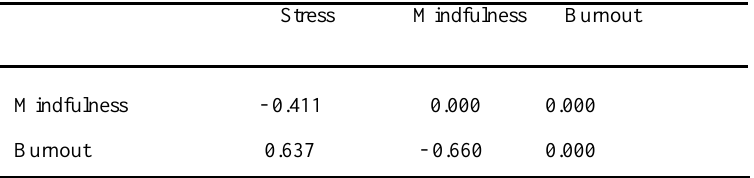
Table 1: Standardized Total effect